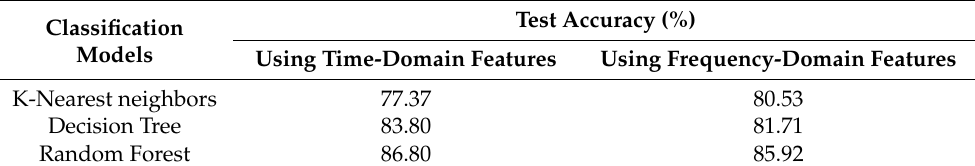
Table 2. Performance measures and comparison of different algorithms for time domain and fre- quency domain features.